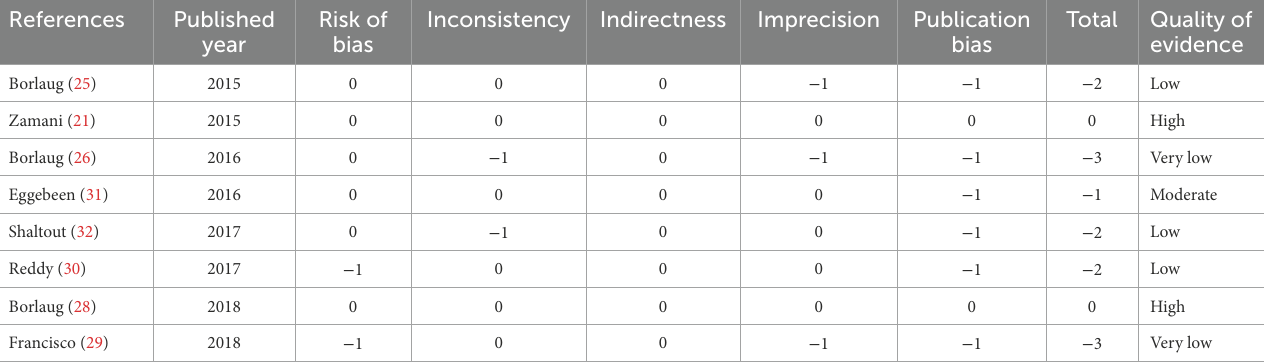
TABLE 2 Grading of evidence quality of included studies according to